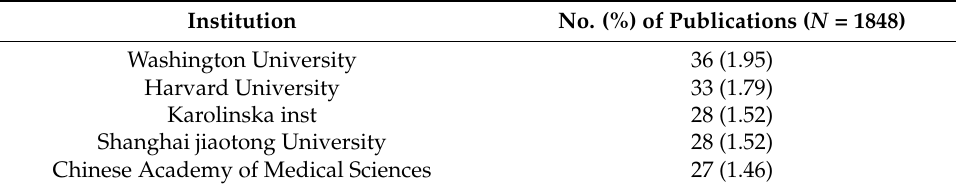
Table 1. Most productive institutions in the field of atherosclerosis.